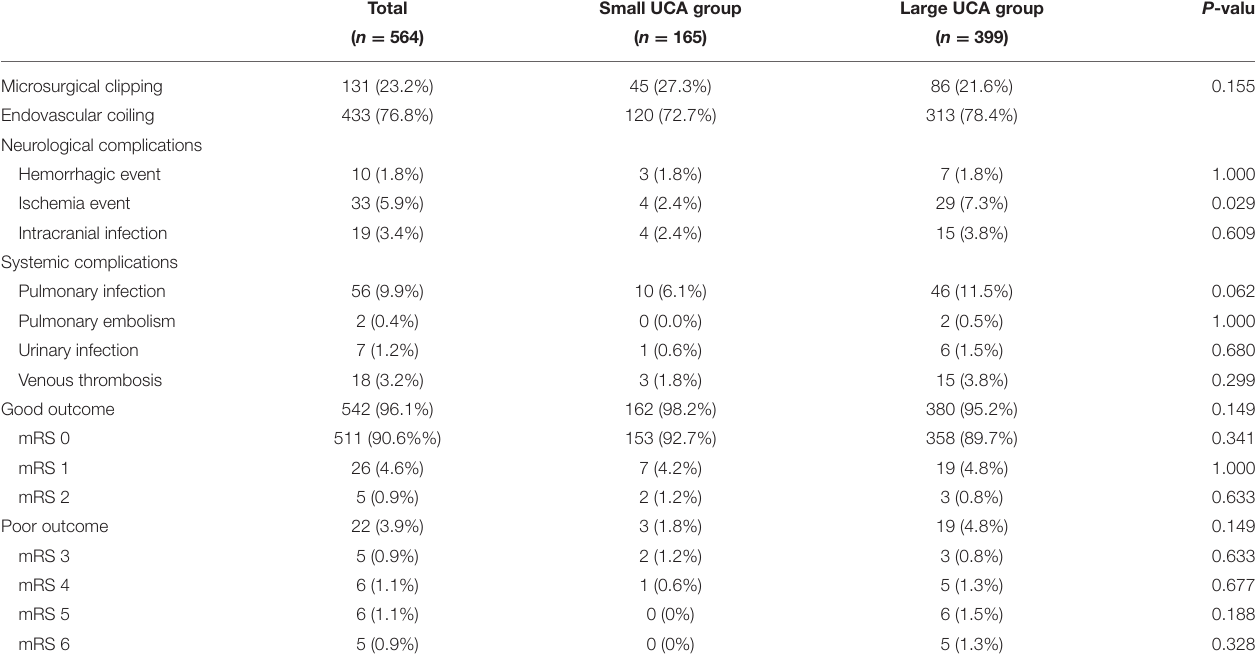
TABLE 3 | Complications and outcome of patients with UCAs, divided into small and large UCA groups.